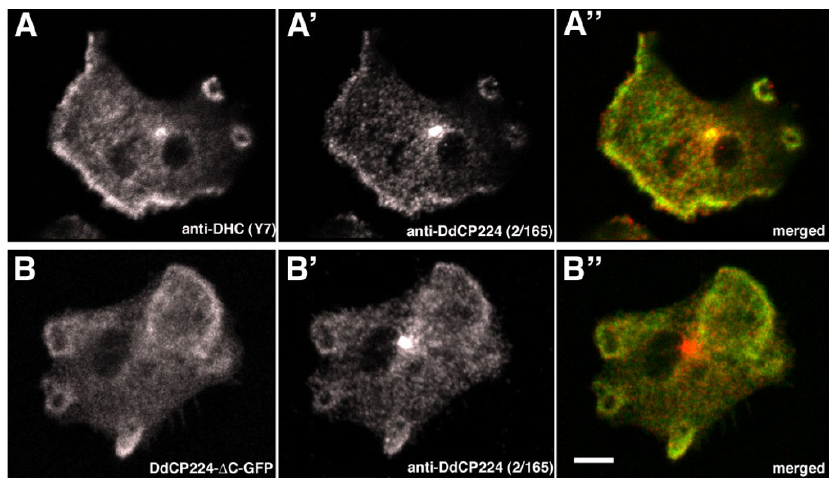
Figure 6 Colocalization of DdCP224, DdCP224- ∆ C-GFP and dynein at the cell cortex. Confocal microscopy of DdCP224- ∆ C-GFP cells showing brightest point projections of immunofluorescence stainings using anti-dynein-Y7 [19] (A) and anti- DdCP224 (2/165) (A', B'). GFP fluorescence is shown in (B). The merged images (A", B") shows endogenous DdCP224 in red and dynein (A) or DdCP- ∆ C-GFP (B'), respectively, in green. Cells were fixed with formaldehyde/acetone. Bar 2 µ m.